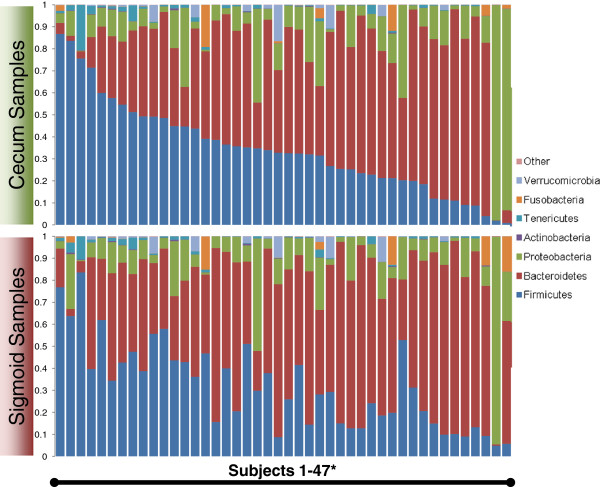
Phylum-level microbial composition of samples used in this study. Data are plotted such that cecum and sigmoid samples from the same individual are vertically aligned. *Some samples were excluded to allow vertical alignment by subjects.